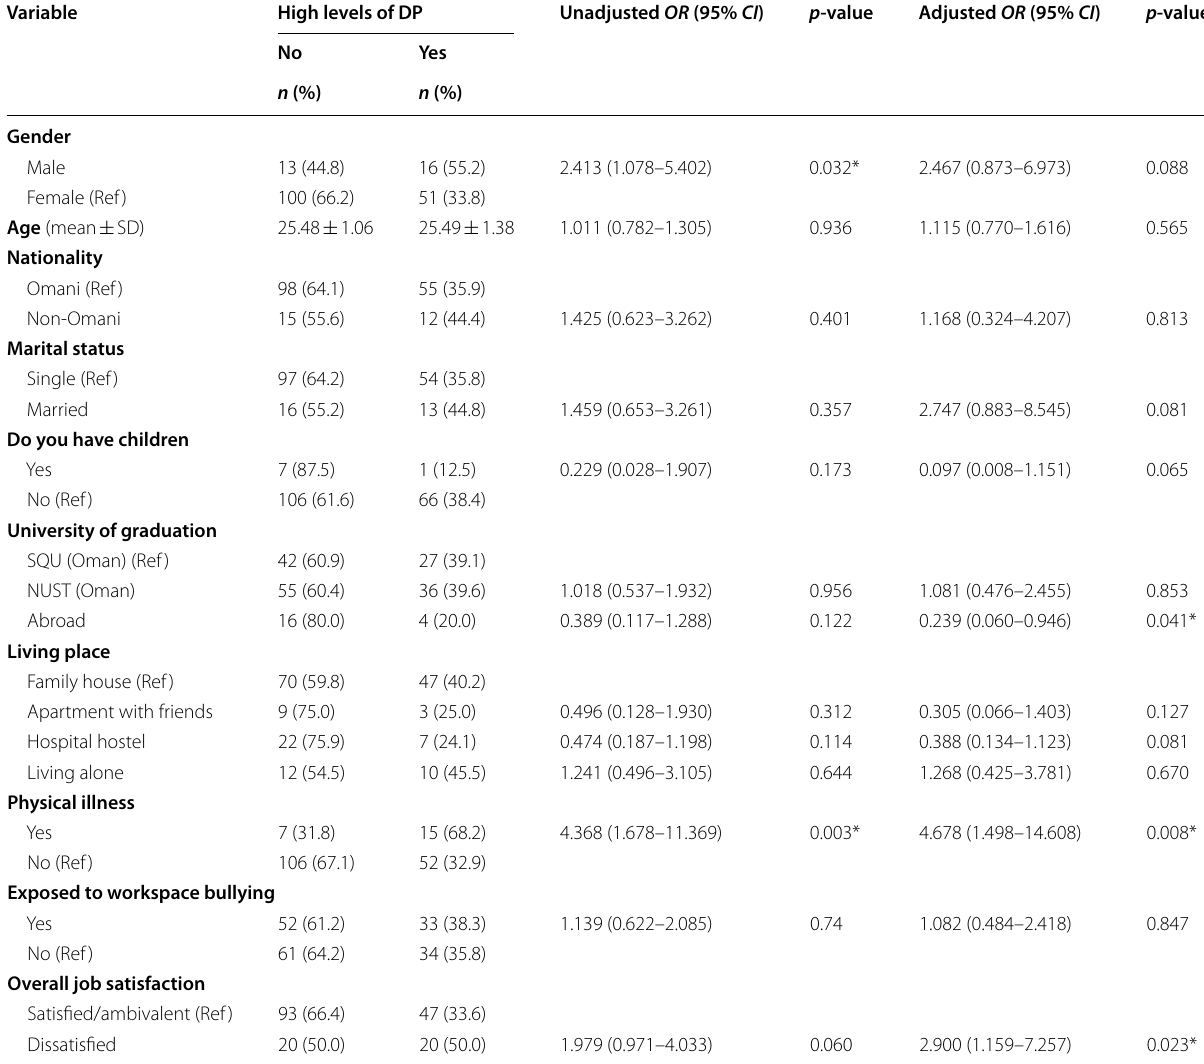
Table 3 The results of univariate and multivariate analysis of data pertain to the high depersonalization (DP) of burnout subscale and explanatory